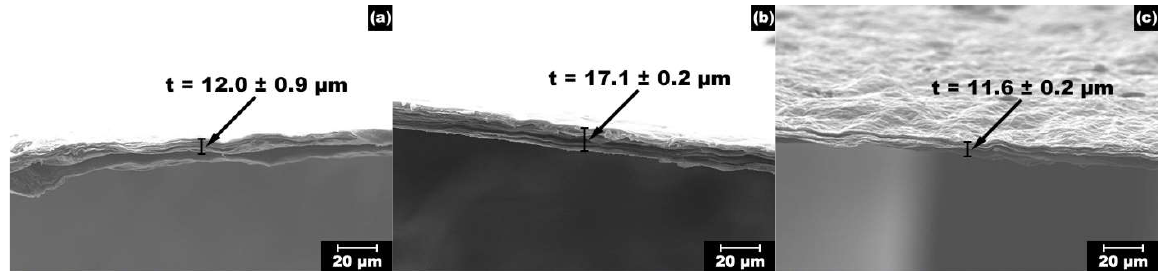
Figure 4. Cross-sectional SEM images at 1000× magnification of the proposed GO-based membranes and their corresponding thicknesses: ( a ) SGO; ( b ) GONS; ( c ) BSGO.